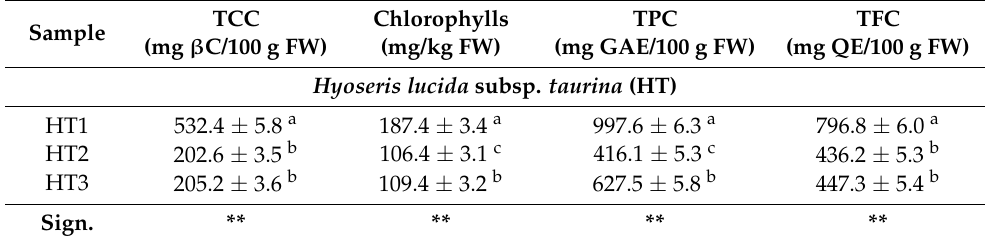
Table 3. Phytochemical content of Hypochaeris and Hyoseris extracts.